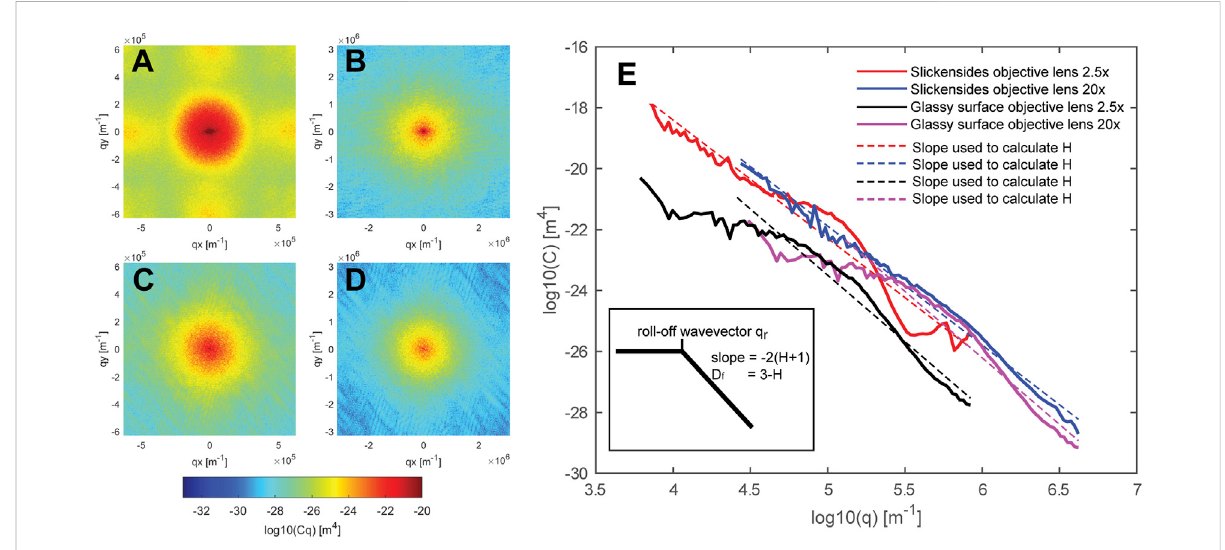
FIGURE 4 Power spectraldensities C 2D related to themeasuredsurfacetopographies depictedinFigure 3. (A) , (B) , (C) ,and (D) havethesamemeaningsas in Figure 3. (E) Radially averaged 2D power spectral densities related to the C 2D s depicted in Figure 3. The sketch shows the important quantities that can be determined from the curves.